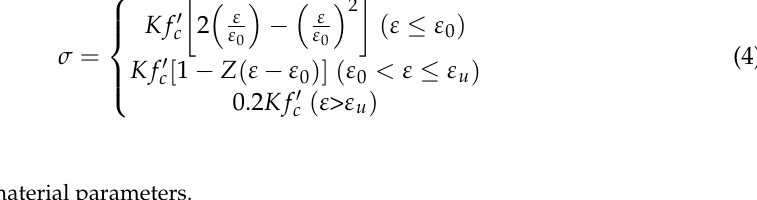
Table 1. iConcrete04 material parameters.